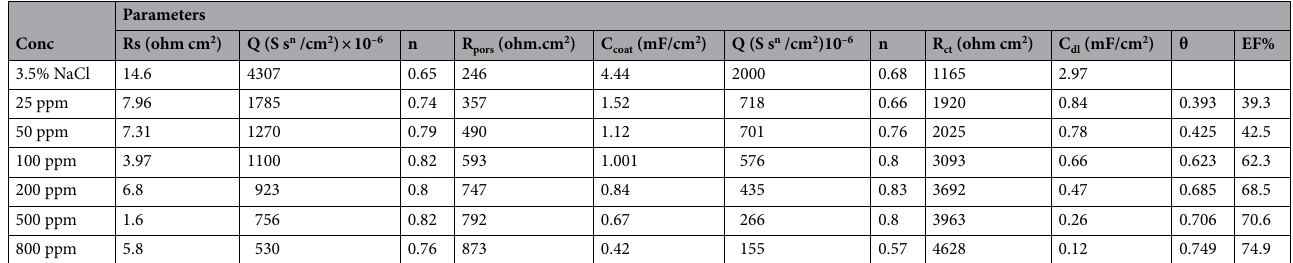
Table 2. EIS parameters for carbon steel in 3.5% NaCl free and containing [BMIm]TfO.